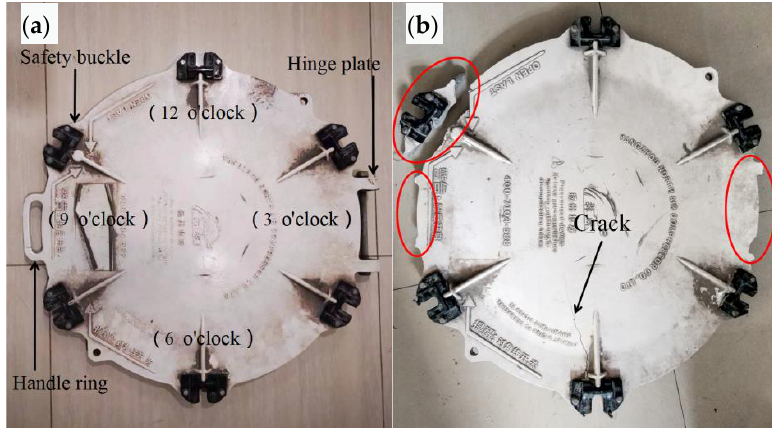
Figure 2. Macro morphology of manhole covers: ( a ) intact, ( b ) cracked.